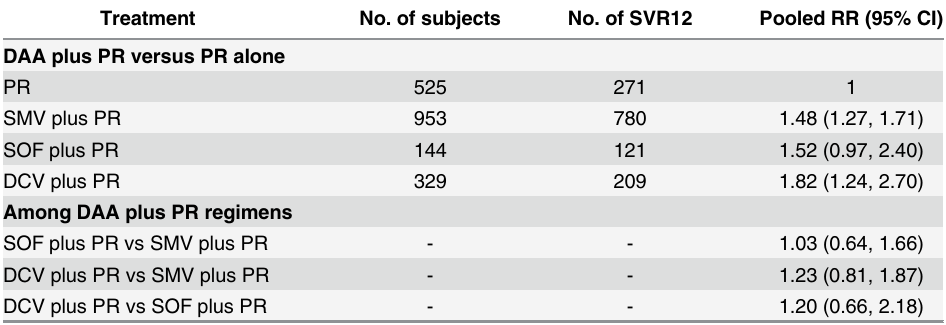
Table 3. Network meta-analysis of sustained virological response at week 12 after the end of